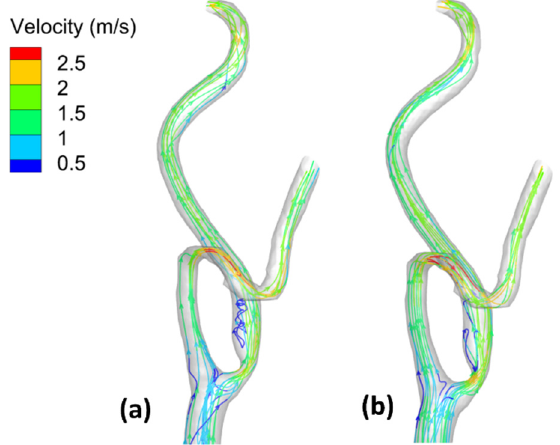
Figure 8. Streamlines at the peak systole for stenotic ICA (model B) of the CA: ( a ) elastic wall, ( b ) rigid wall.